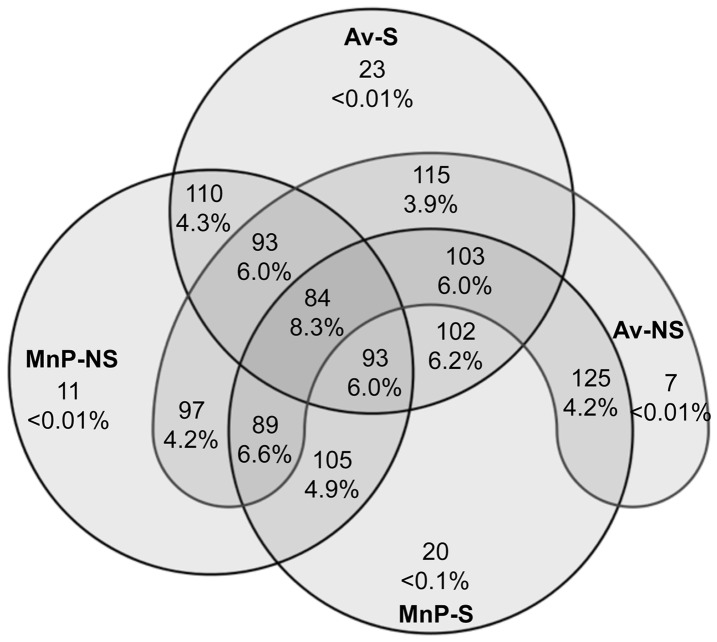
Venn diagram for genus-level OTUs.Number of shared and unique taxa at the genus level among four sites using the criterion that >60% of the replicates in a given sowing sample contain sequences belonging to that OTU. Percentages denote the proportion of shared reads over the total reads obtained and the sites are shown by their abbreviations. Overlapping areas indicate shared taxa among sites. Av-S (Avon suppression), Av-NS (Avon non-suppression), MnP-S (Minippa suppression), MnP-NS (Minippa non-suppression).